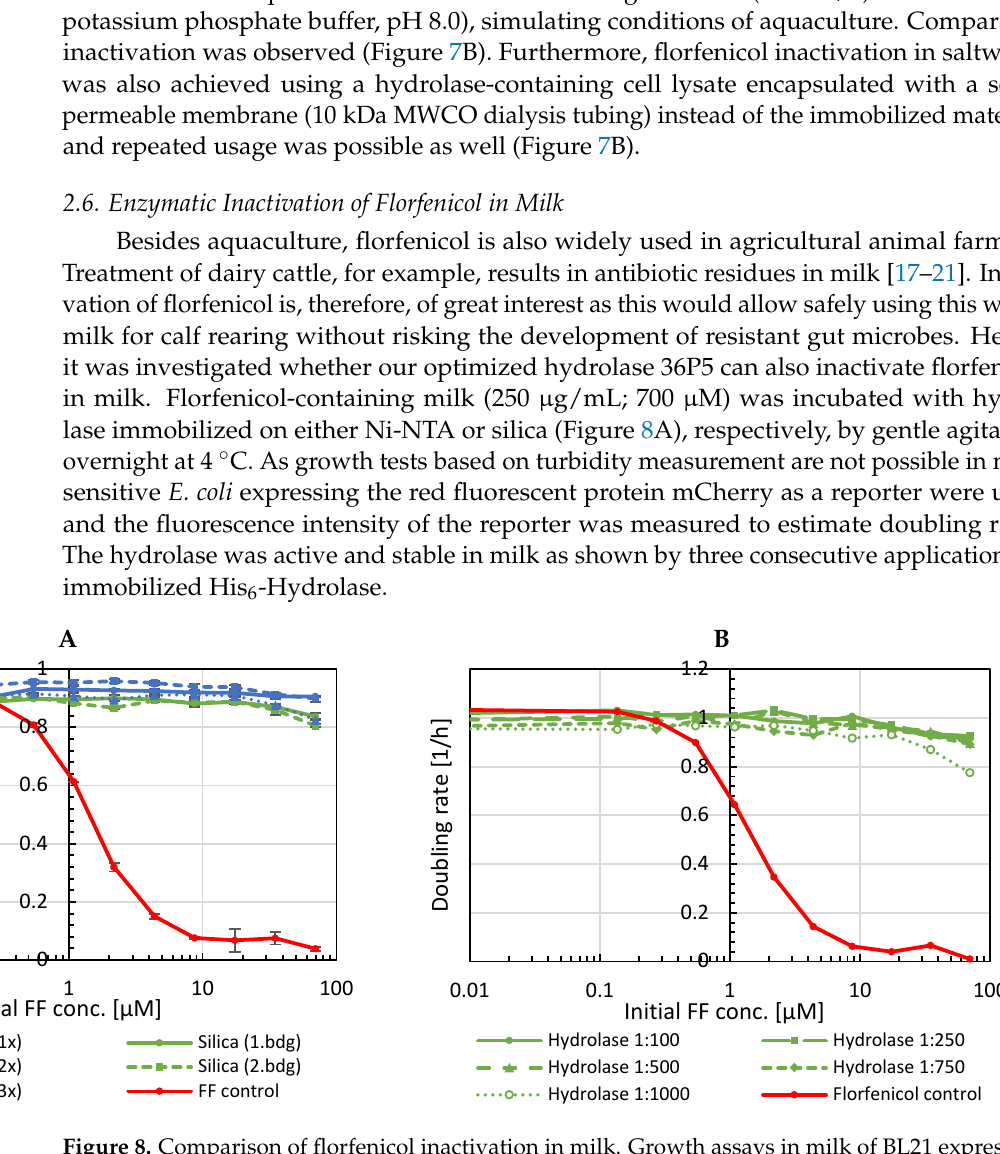
Figure 8. Comparison of florfenicol inactivation in milk. Growth assays in milk of BL21 expressing mCherry after overnight incubation of FF-containing milk ( A ) with hydrolase immobilized on Ni-NTA or silica or ( B ) after addition of crude cell extract with hydrolase.